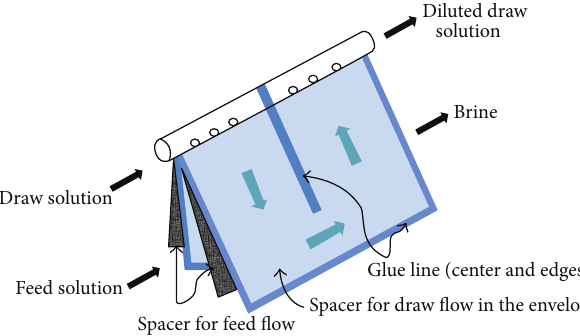
Figure 1: Schematic diagram of a spiral wound forward osmosis (FO) module showing the direction of water in the